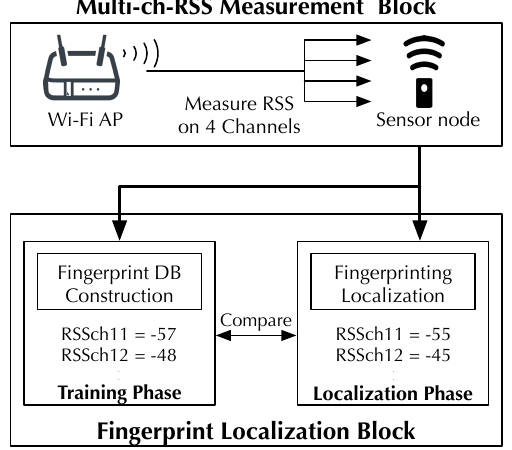
Figure 2. Overview of